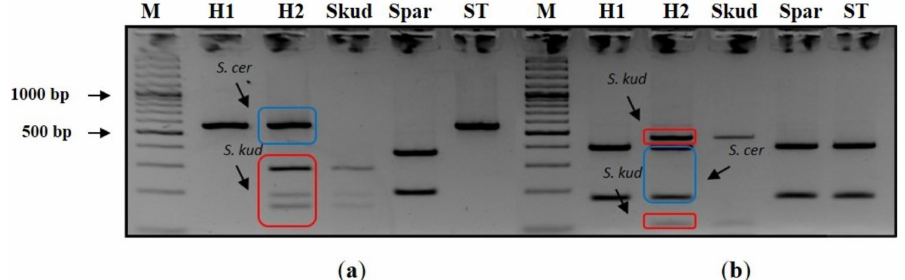
Figure 2. Patterns of CYR1 PCR fragment after digestion with Hae III ( a ) and Msp I ( b ) restriction enzymes, H1, H2: isolates investigated, Skud: S. kudriavzevii CBS 8840, Spar: S. paradoxus CBS 432, ST: Fermol Elegance S. cerevisiae starter strain, M: molecular weight standard, Gene ruler 100 bp (ThermoFisher Scientific, Waltham, MA, USA). Blue and red rectangles represent S. cerevisiae and: S. kudriavzevii specific fragments, respectively. The figure was constructed based on different photos of